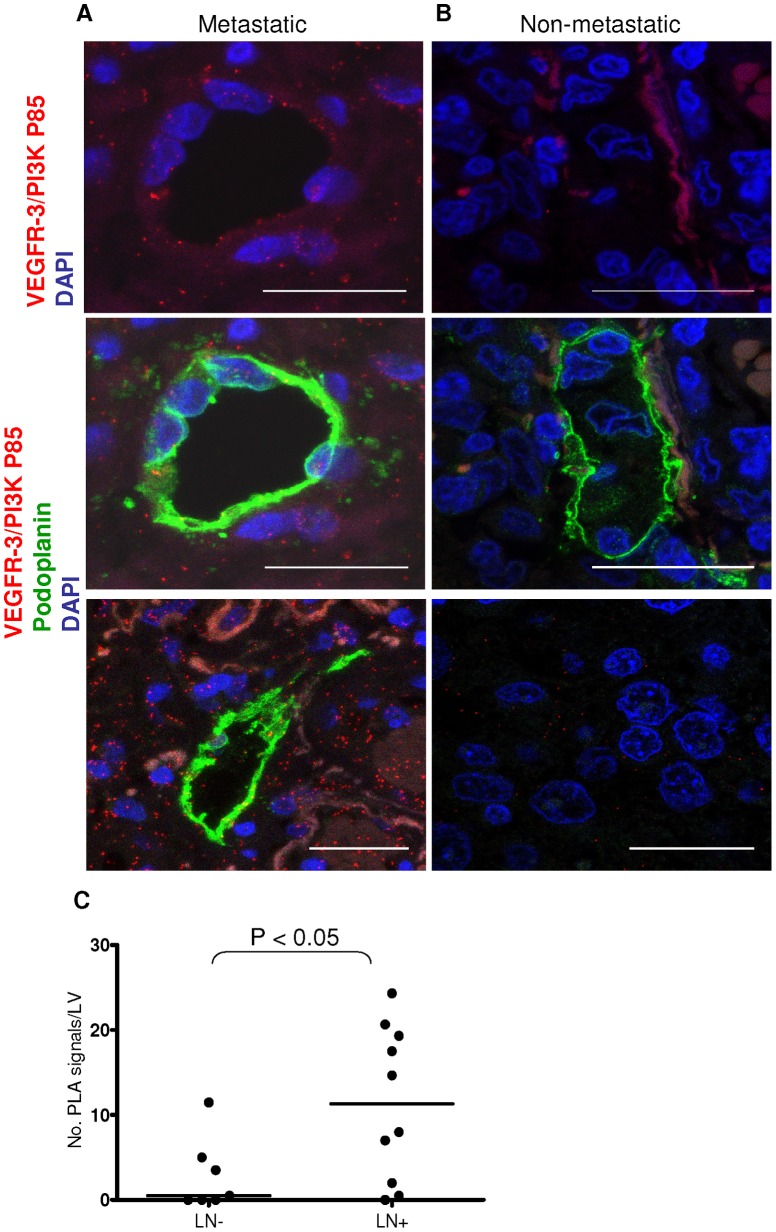
Direct interaction between PI3K p85 and VEGFR-3 in metastatic small cell lung carcinoma.VEGFR-3/PI3K complexes (red) detected by in situ PLA in lung tumor area and lymphatic vessels (green, podoplanin). Lymphatic vessel VEGFR-3/PI3K signals (red) and their representative co-staining with podoplanin (green) in metastatic (A, top and middle panel, respectively) and non-metastatic (B, top and middle panel, respectively) in small cell lung cancer tissue. VEGFR-3/PI3K signals were detected in cancer cells surrounding the lymphatic vessels in the metastatic samples (A, top and bottom panel) as well as the lymphatic vessels; whereas the low signal in non-metastatic samples was detected mostly away from the lymphatic vessels (B, bottom panel), and not in tumor cells inside or surrounding the non-metastatic lymphatic vessels (B, top and middle panels). Bar, 25 µm. DAPI (blue); C. Quantification of PLA signals (at least 5 different regions in each sample) in the lymphatic vessels (LV) (C, left) in lymph node negative (LN-; n = 7; two samples were excluded because there were no lymphatic vessels present in the sections examined) and lymph node positive (LN+; n = 10) samples using Olink Imaging Software. Plotted are mean values for individual patients. Line represents median value. *P<0.05.